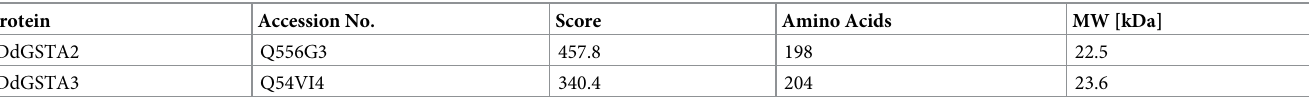
Table 3. Mass Spec analysis of purified rDdGSTA2 and rDdGSTA3. Protein Accession No.